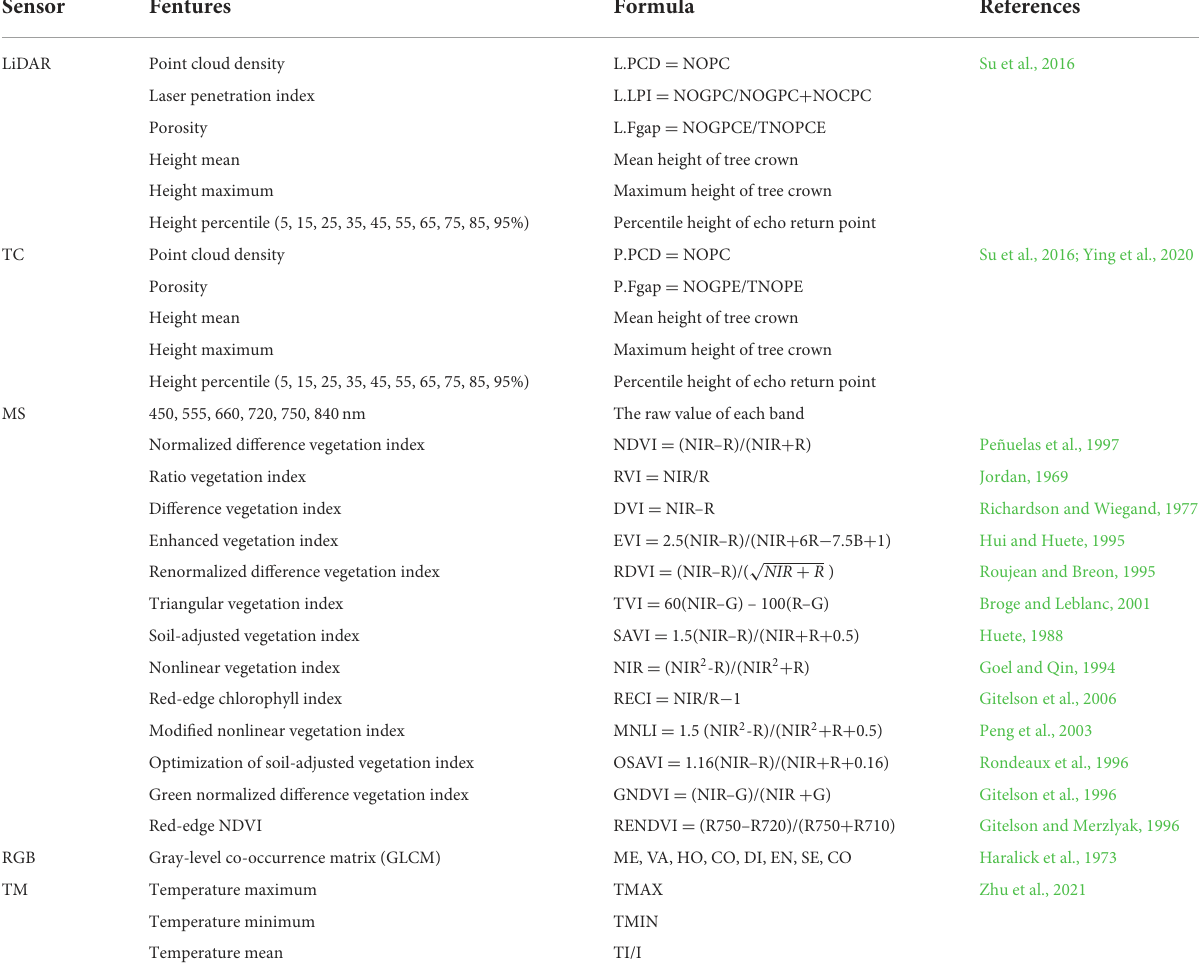
TABLE 4 Definitions of the features extracted from different sensors and